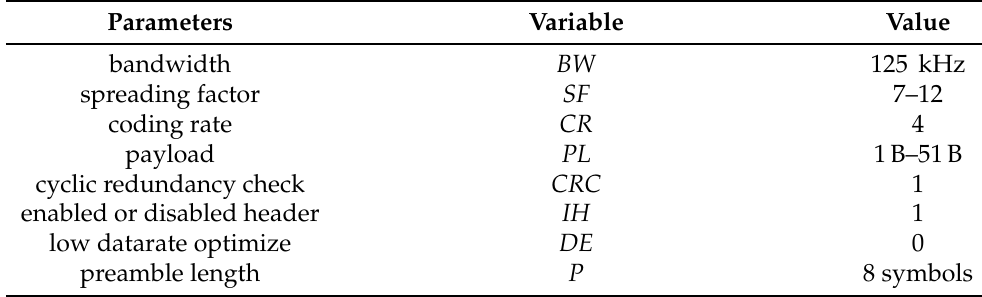
Table 2. LoRa message parameter